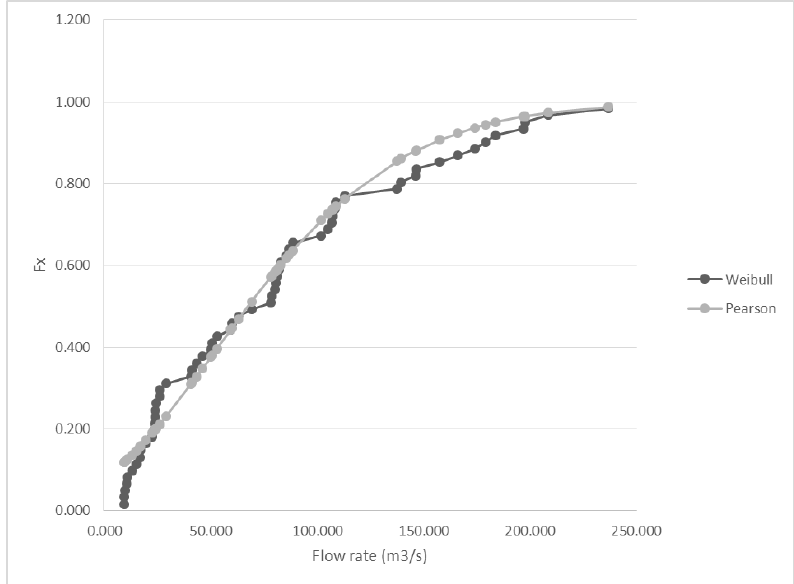
Figure 6. Kolmogorov – Smirnov goodness of fit test.